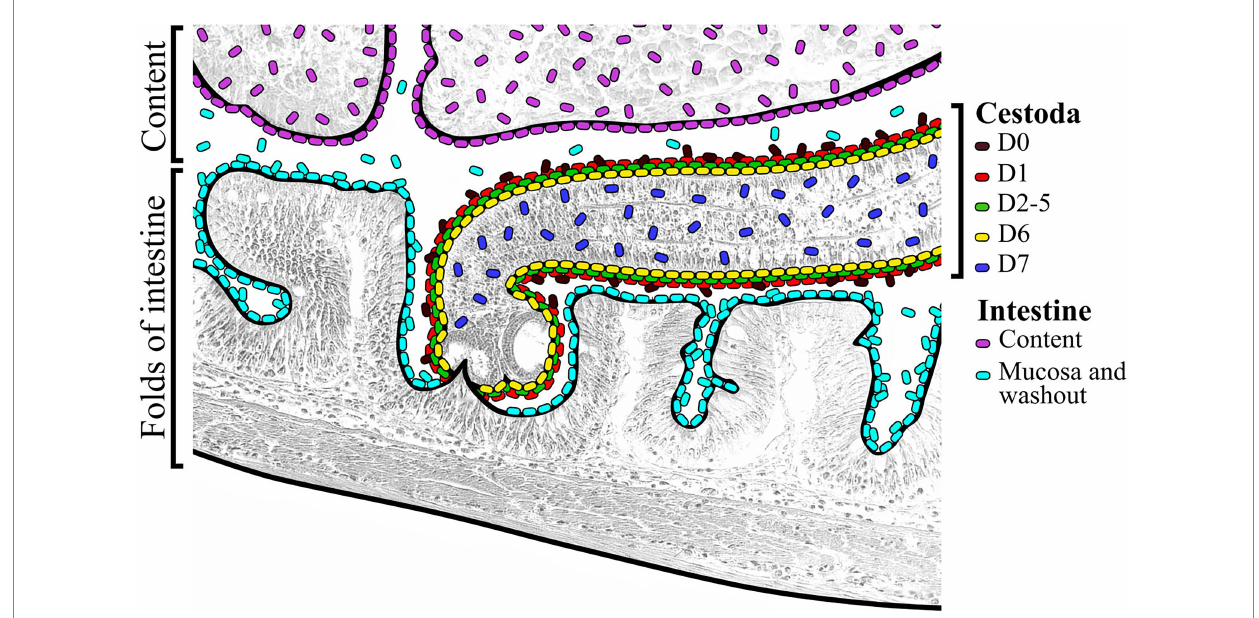
FIGURE 8 Schematic view of organization of different microbial communities associated with infected “normal” C. l. pidschian and the cestodes, Proteocephalus sp. parasitizing the intestine of